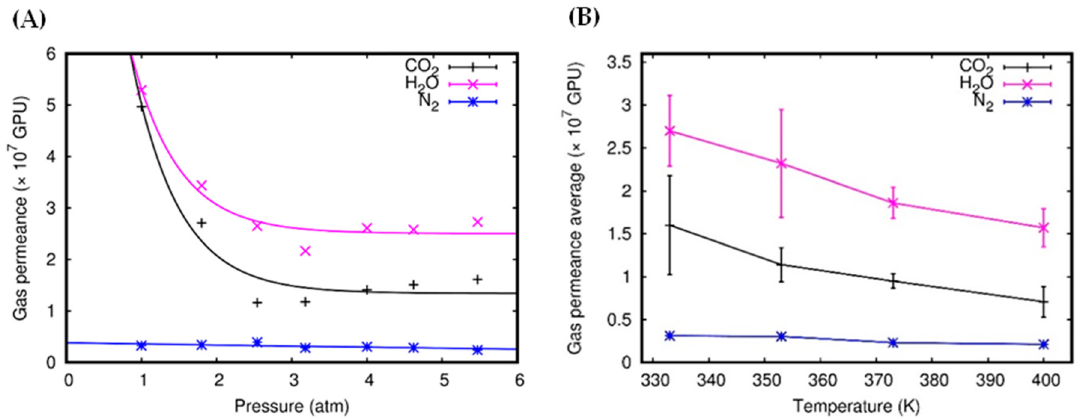
Figure 3. Gas permeance of the single-layer system at 333 K ( A ) and gas permeance average of the single-layer system as a function of temperature ( B ).